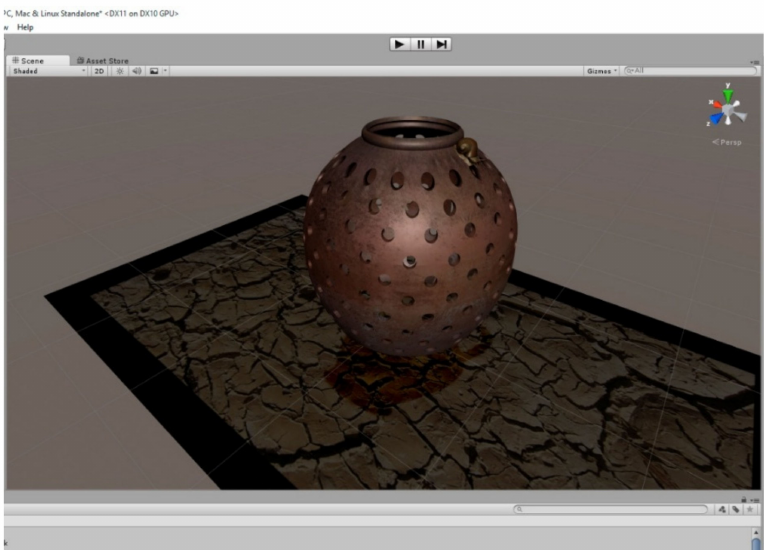
Figure 6. 3D model of a pottery jar integrated and visualized in